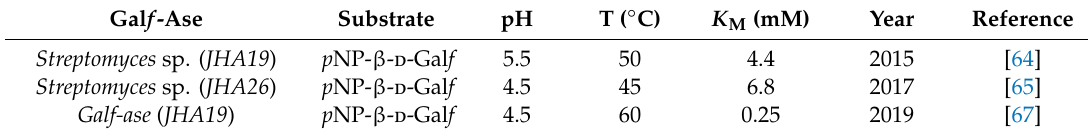
Table 2. Comparative properties of recombinant β - d -galactofuranosidases. Gal f